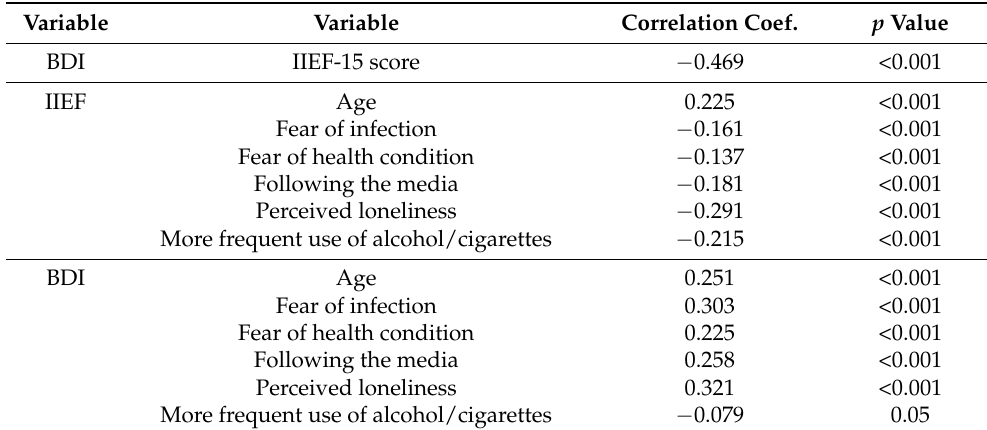
Table 5. Correlations between Beck Depression Inventory scores, International Index of Erectile Function-15 scores, and other variables (Spearman’s rank correlation